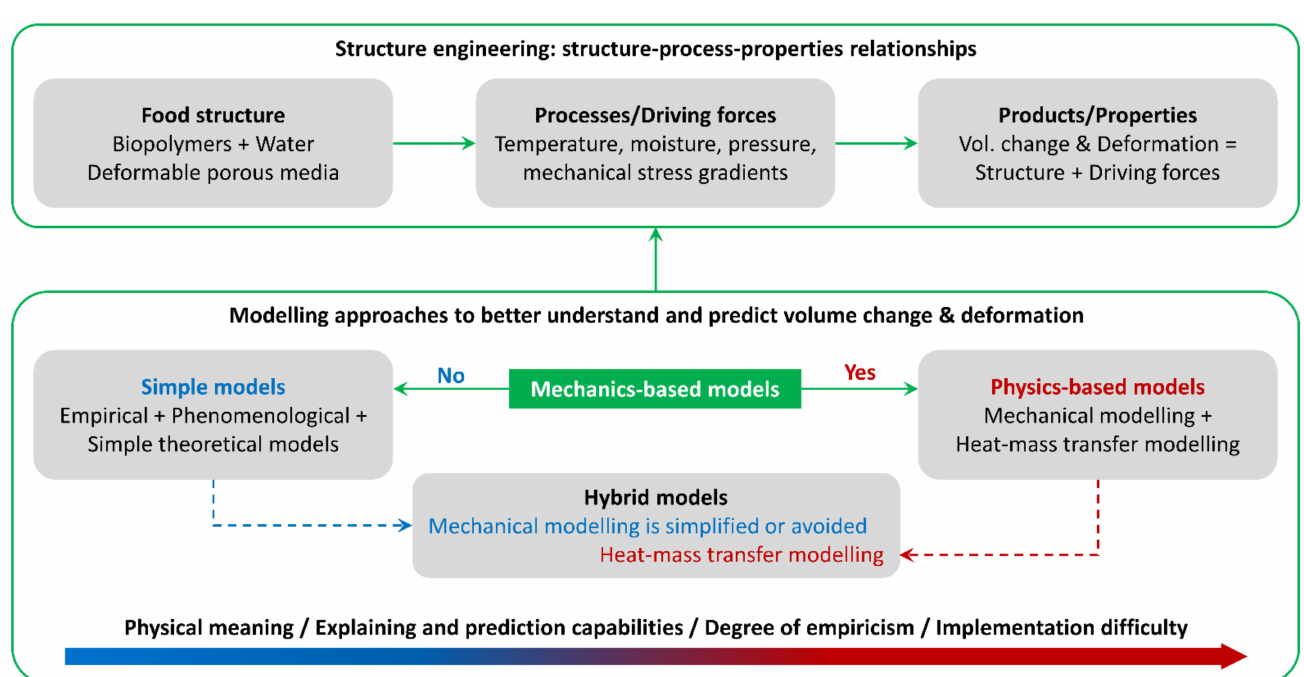
Figure 1. Graphical summary of the review article, including general perspective and modelling approaches, according to the proposed